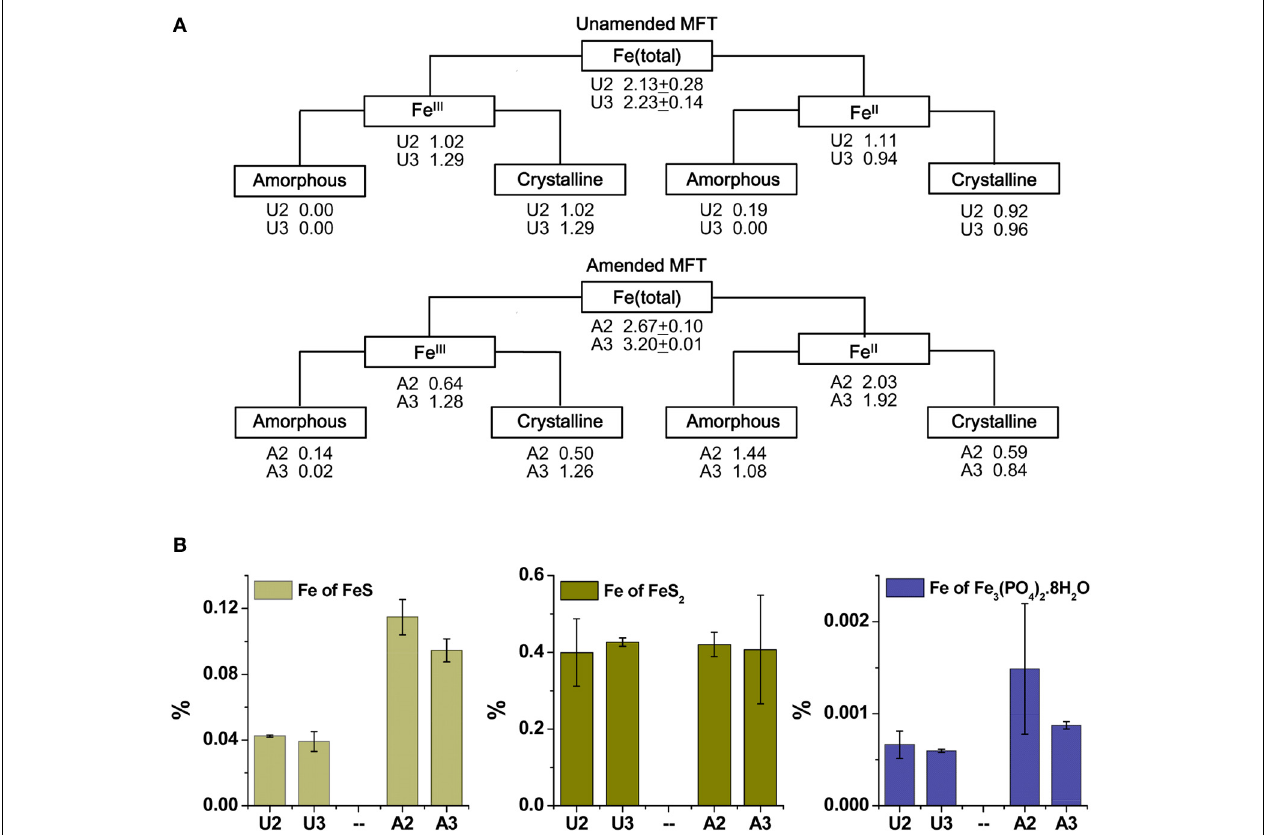
FIGURE 3 | Iron (Fe) transformation observed in unamended (U) and amended (A) MFT at 213 days incubation. Labels A2 through U3 designate the columns and ports used to withdraw MFT samples below the mudline. (A) Fe fractionation ( Table 2 ) calculated in % (oven dry basis): Fe (total) = Fe (acid digested Fe); Fe III = Fe (dithionite-citrate-bicarbonate; DCB) – Fe II (ferrozine); Fe III (amorphous) = Fe (ammonium oxalate extraction; AOD) − Fe II (siderite) − Fe (acid volatile sulfides; AVS) − Fe (ferrozine); Fe III